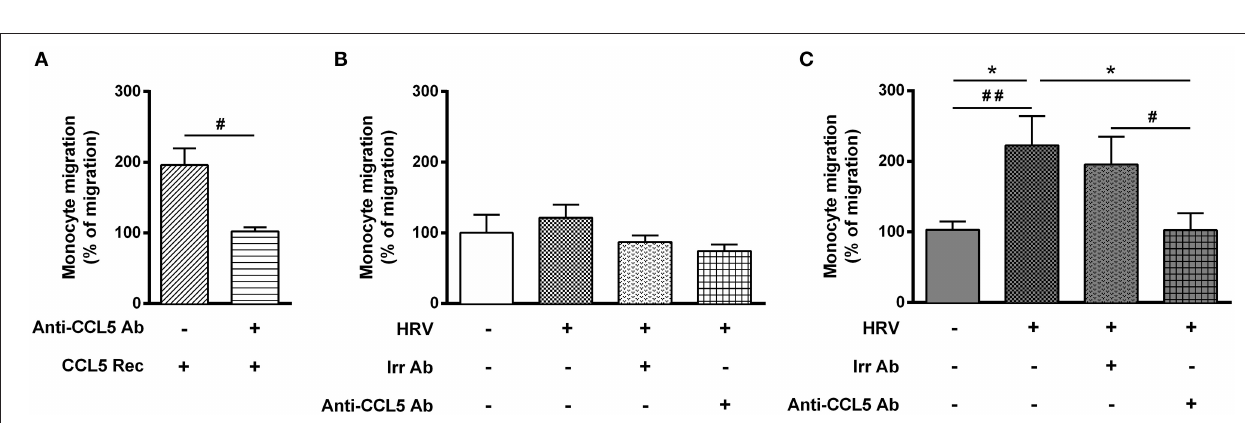
FIGURE 4 | Increase rhinovirus-mediated monocyte migration induced by asthmatic bronchial smooth muscle is CCL5 dependent. Monocyte migration was assessed in response to recombinant CCL5 (CCL5 Rec) (A) as a positive control, or to supernatants of reconstituted bronchial epithelial cells in air liquid interface co-cultured with bronchial smooth muscle cells from (B) control ( n = 6–9 per group) or (C) asthmatic patients ( n = 6–8 per group). The effect of CCL5 on rhinovirus-induced monocyte migration was evaluated by addition of blocking antibody (Anti-CCL5 Ab). Data are presented as mean ± SEM values of three independent experiments (Wilcoxon test, # P < 0.05; ## P < 0.01 and ordinary one way anova, Bonferroni’s multiple comparisons test, * P < 0.05 compare the mean of HRV + alone with the mean of every other